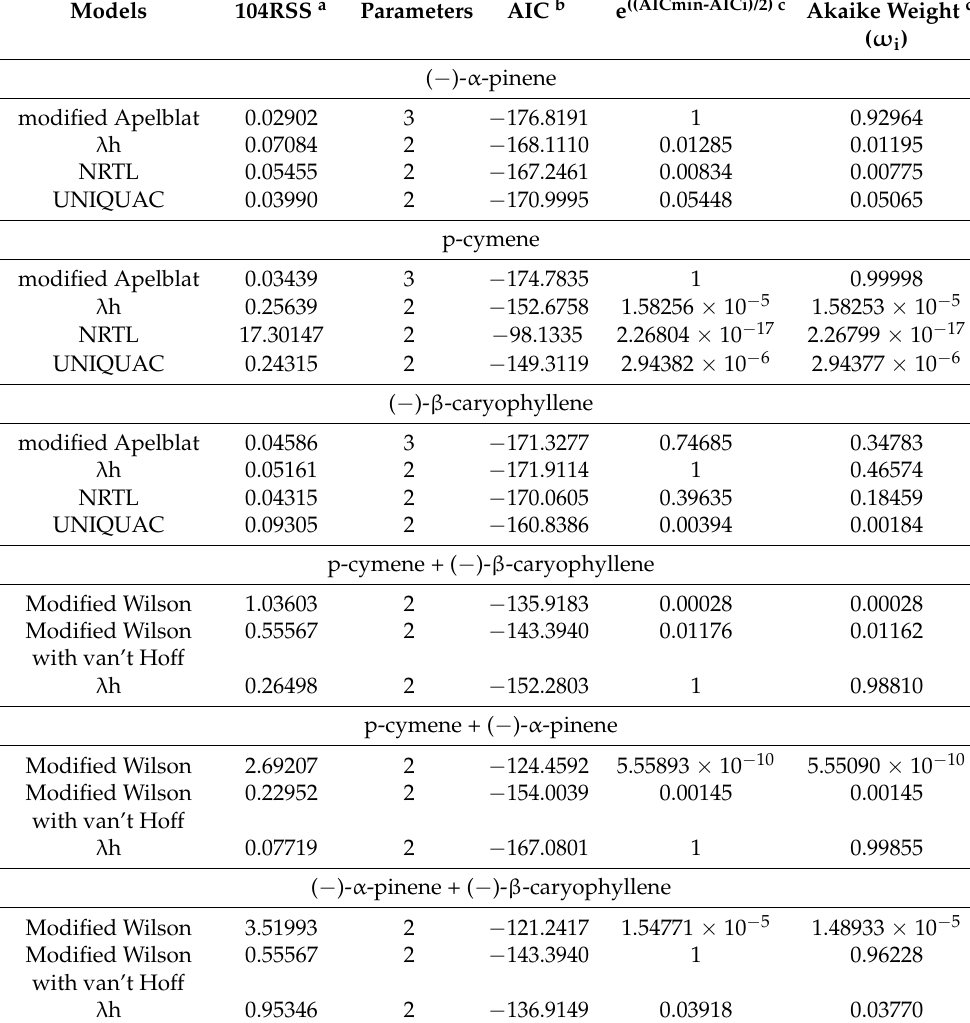
Table 11. Value of the Akaike Information Criterion (AIC) of the fitting model for dehydroabietic acid in the different